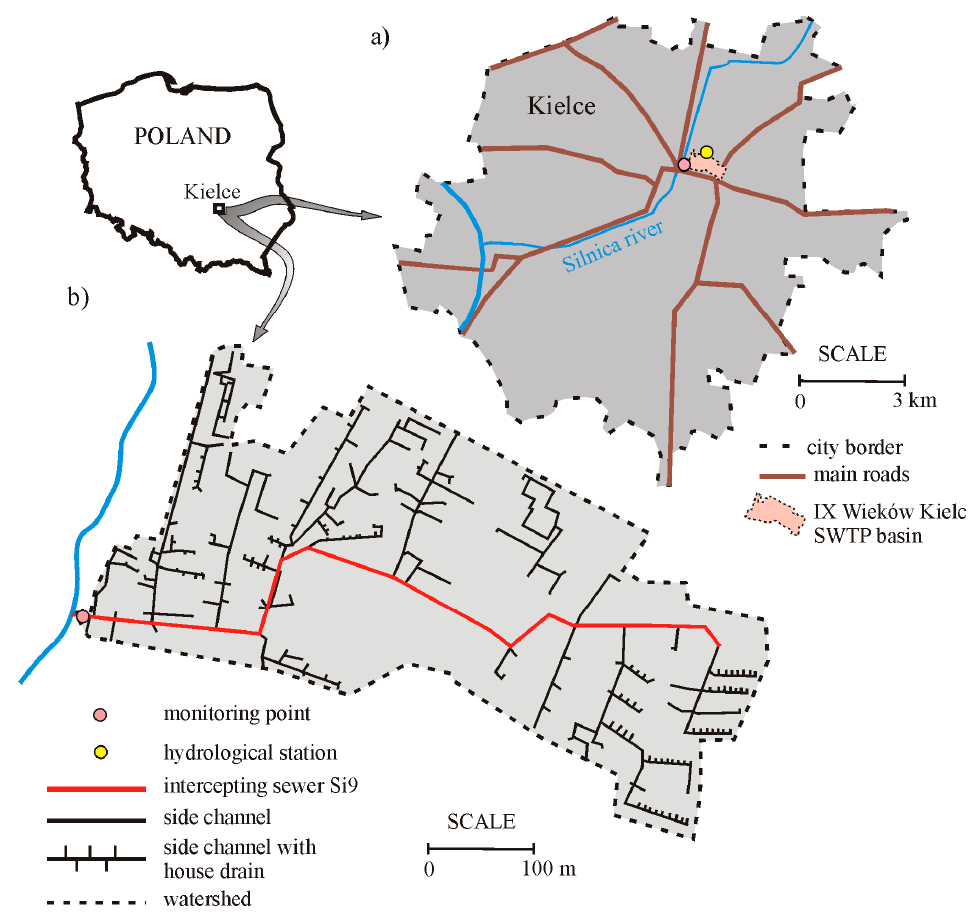
Figure 1. Study area: ( a ) location of the catchment in the city of Kielce; ( b ) sewage network system. Before being discharged to the receiver (the Silnica river), the stormwater is pre–treated at the stormwater treatment plant (SWTP) located in IX Wieków Kielc street (Figure 2). The facility consists of two horizontal settling tanks with a length of 30 m each, and a coalescence separator with a diameter of 3.0 m.